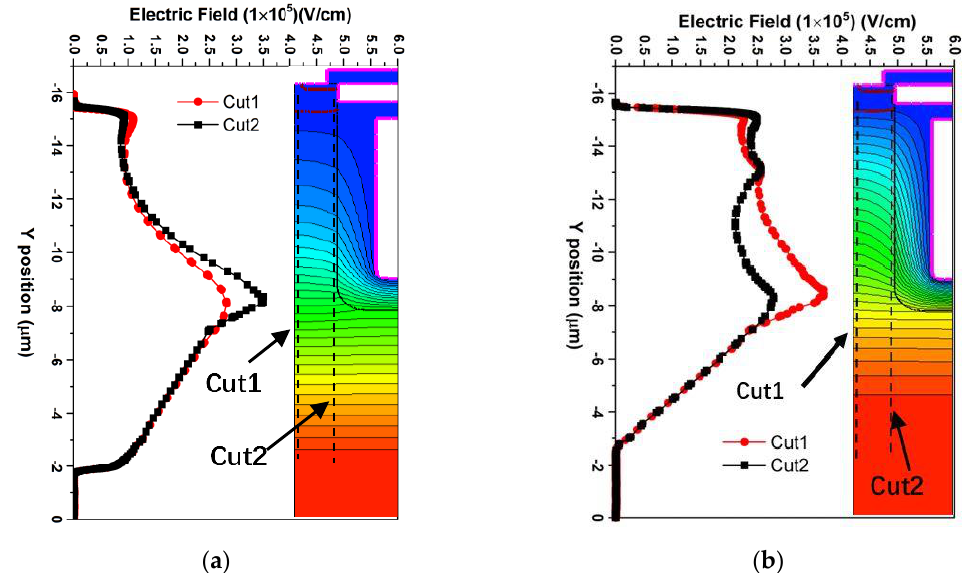
Figure 2. Potential distribution and electric field from cutlines comparing of the ( a ) SGRSO and ( b ) HDSGRSO UMOSFET at V DS = 240 V.